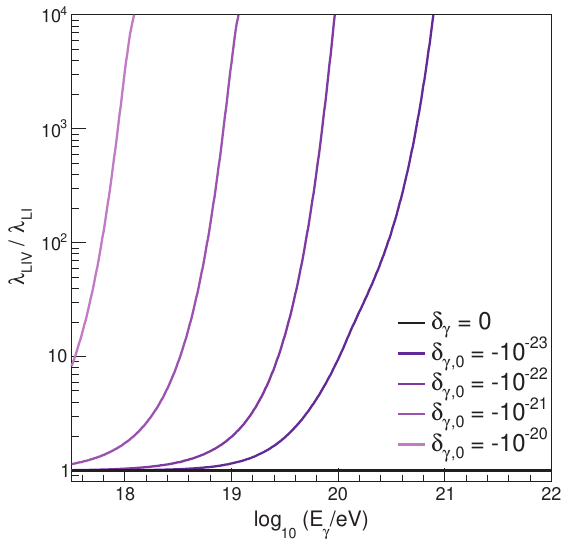
Figure 1. Ratio of the mean free path of pair production as a function of energy when LIV and LI are considered. The black line represents the LI case, while the shades of purple represent di ff erent LIV coe ffi cients. Figure from